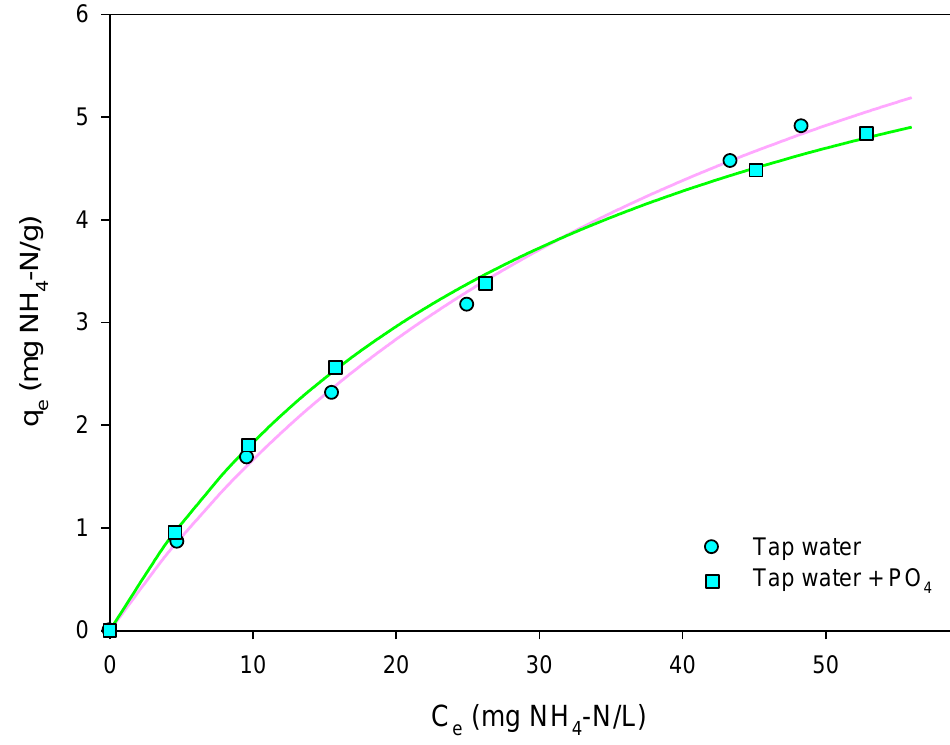
Figure 5. Comparison of isotherms performed with tap water and tap water fortified with PO 4 . Only the Langmuir model fit shown .